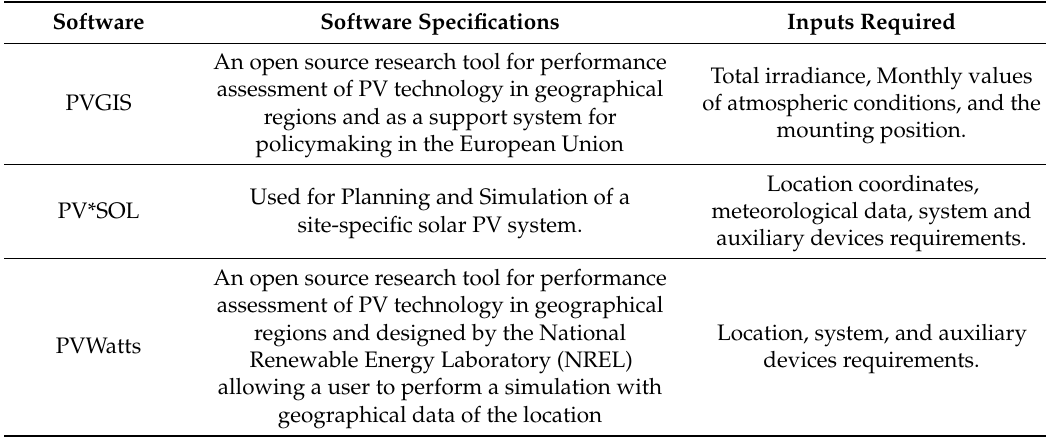
Table 3. Software used in the current